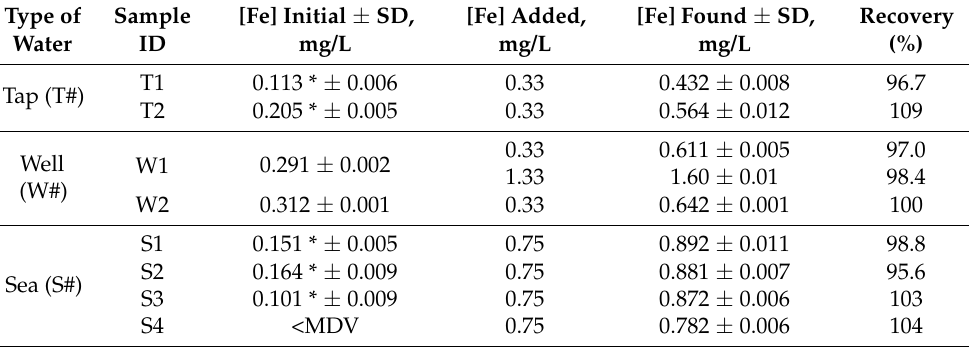
Table 3. Recovery percentages calculated from spiked natural waters assessed with the developed paper-based method, MDV, minimum detectable value.